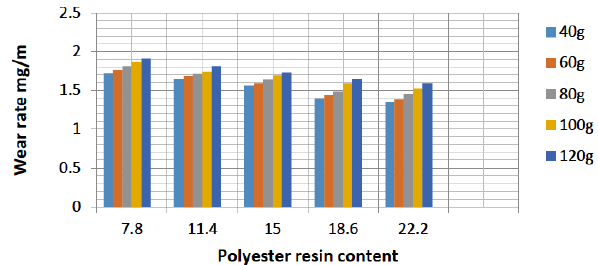
formed at the two temperatures to understand their wear characteristics under heat resulting from the frictional ap- plication or action of the sandpaper. Based on the grit sizes of 250 µm and 420 µm at different concentrations of the palm kernel and coconut shells, specimens were evaluated.